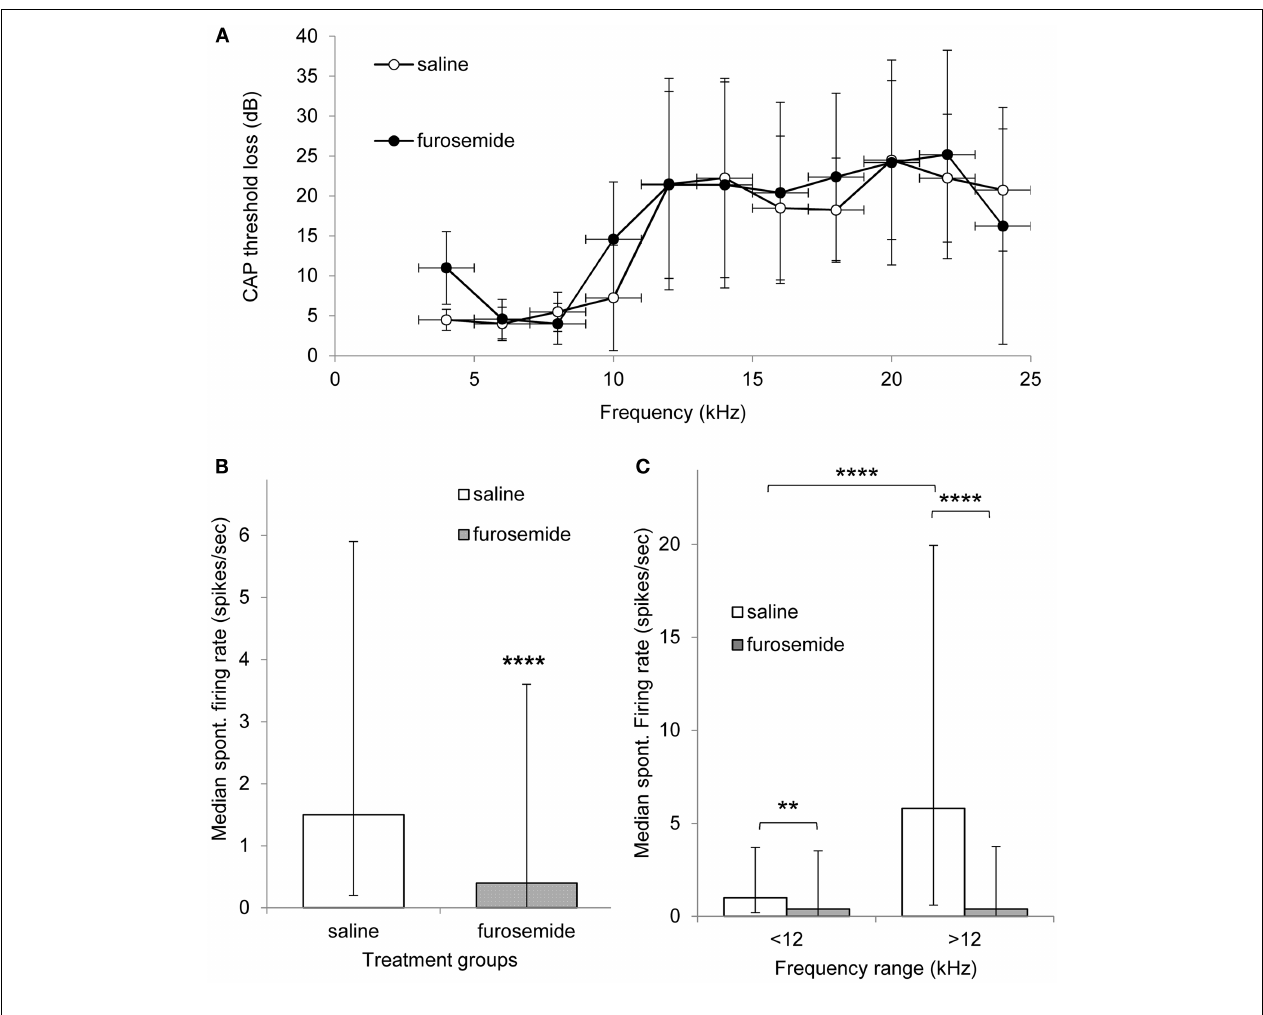
12days after acoustic trauma. Median shown with 25 and 75% percentile. (C) Histogram showing median spontaneous firing rate of CNIC neurons in high and low frequency regions in saline treated animals (white bars) and furosemide treated animals (black bars) on day 12 after acoustic trauma. Bars show median with 25 and 75% percentile ** p < 0.01; **** p <